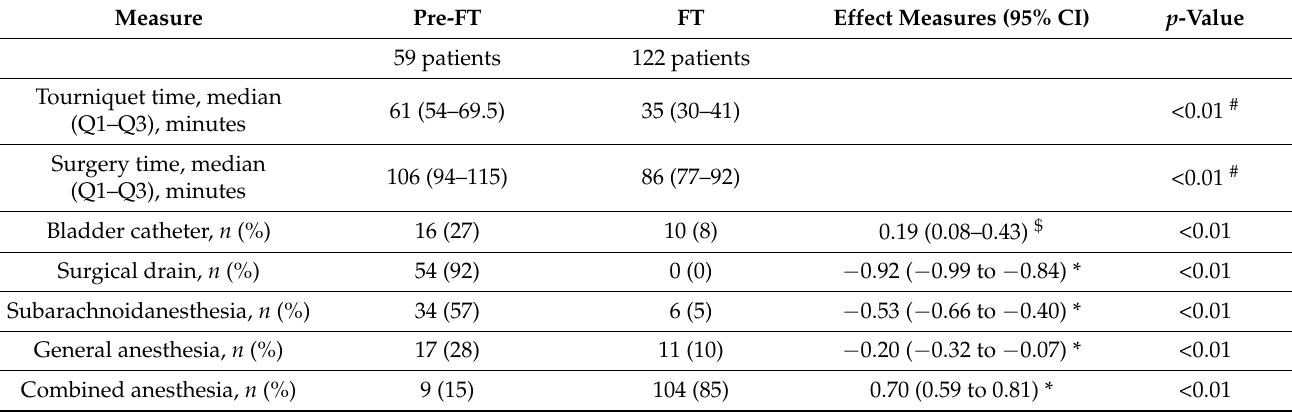
Table 4. Impact of the FT protocol on the process of care of the two patient